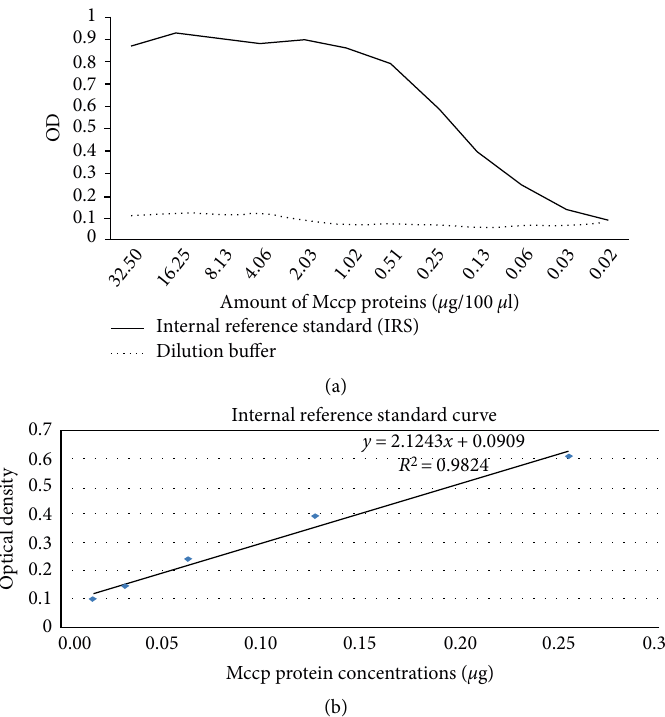
Figure 5: Determination of internal reference curve (a) represents the titration of IRS, (b) represents the standard curve derived from internal reference sample from which estimates of other tested vaccines were